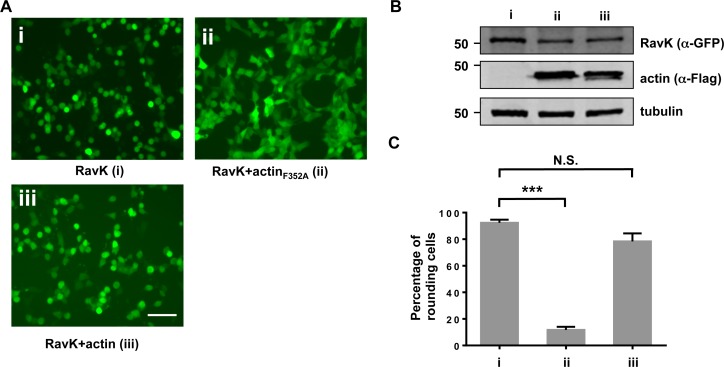
ActinF352A suppresses the cell rounding phenotype caused by RavK.A. ActinF352A but not wild-type actin suppressed the cell rounding phenotype caused by RavK. HEK293T cells were transfected with (i) pEgfp-ravK alone, (ii) pEgfp-ravK together with pCMV-Flag-actin or (iii) pEgfp-ravK together with pCMV-Flag-actinF352A for 24 h, and were observed under a fluorescence microscope. Bar, 50 μm. B. Expression of GFP-RavK, Flag-actin or Flag-actinF352A. Cells were transfected by indicated plasmids for 24 h, and the cleared lysates from transfected samples were resolved by SDS/PAGE, and subjected to immunoblotting with antibodies specific to GFP and the Flag tag, respectively. α-tubulin was used as a loading control. C. Quantification of the percentage of green cells exhibiting the cell rounding phenotype. Experiments were performed in triplicate and at least 200 cells were examined in each sample. Error bars indicate standard error of the mean (SEM); N.S., not significant; ****, p<0.0001. Similar results were obtained in three independent experiments.